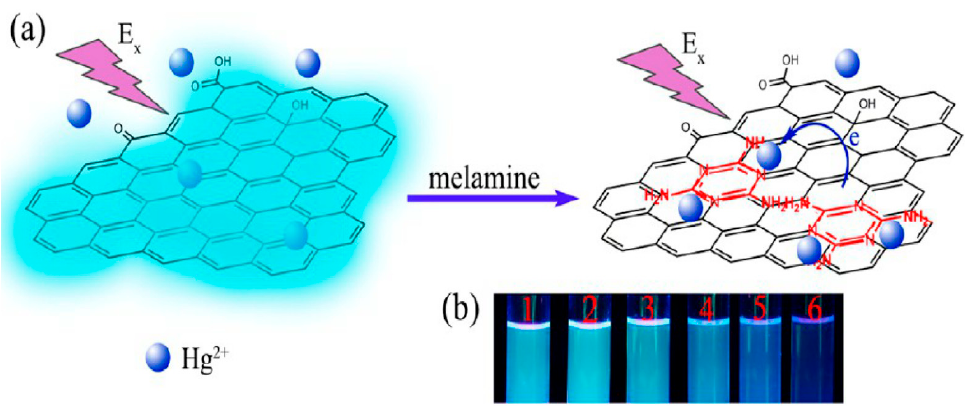
Figure 3. ( a ) Schematic illustration of melamine detection based on Fluorescence (FL) quenching of graphene quantum dots (GQDs) through charge transfer. ( b ) Optical photos of solutions of